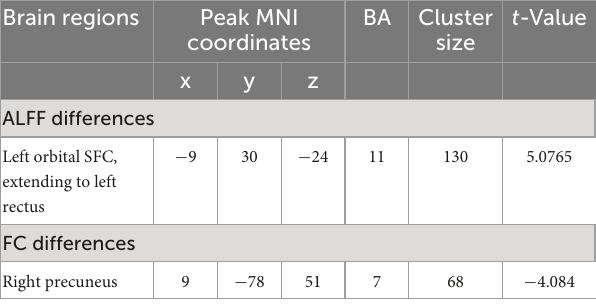
TABLE 2 Differences in ALFF and FC values between CRS patients and HCs. Brain